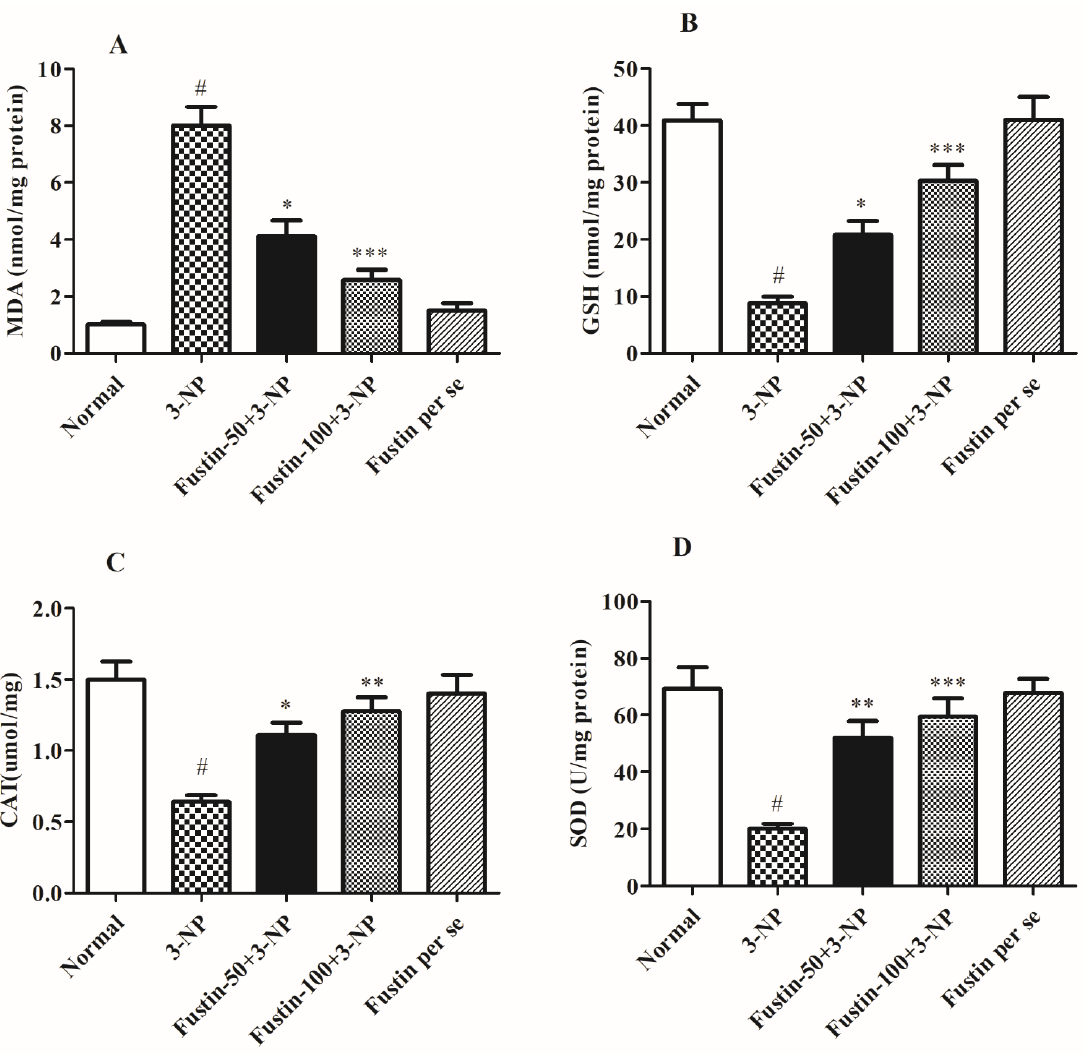
Figure 5. Effect of fustin on endogenous parameters against 3-nitropropionic acid-induced Huntington’s-like effects in rats ( A ) MDA, ( B ) GSH, ( C ) CAT, ( D ) SOD. Values are expressed as mean ± S.E.M. ( n = 6). Values are statistically significant at # p < 0.05 vs. negative control group, * p < 0.05 vs. 3-nitropropionic acid, ** p < 0.01 vs. 3-nitropropionic acid, *** p < 0.001 vs. 3-nitropropionic acid, respectively (One-way ANOVA followed by Tukey’s test).